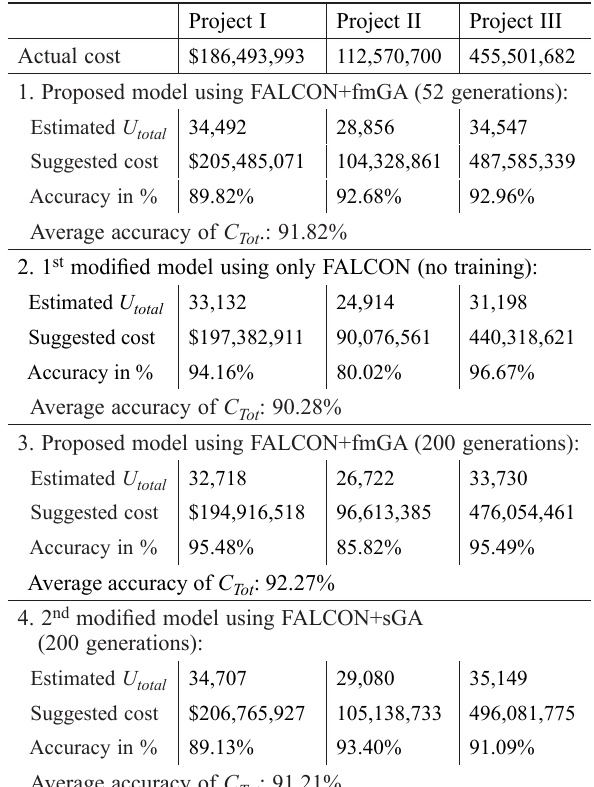
Table 8. Comparisons of evaluation results of C Tot using the proposed and modified models in the three case projects Project